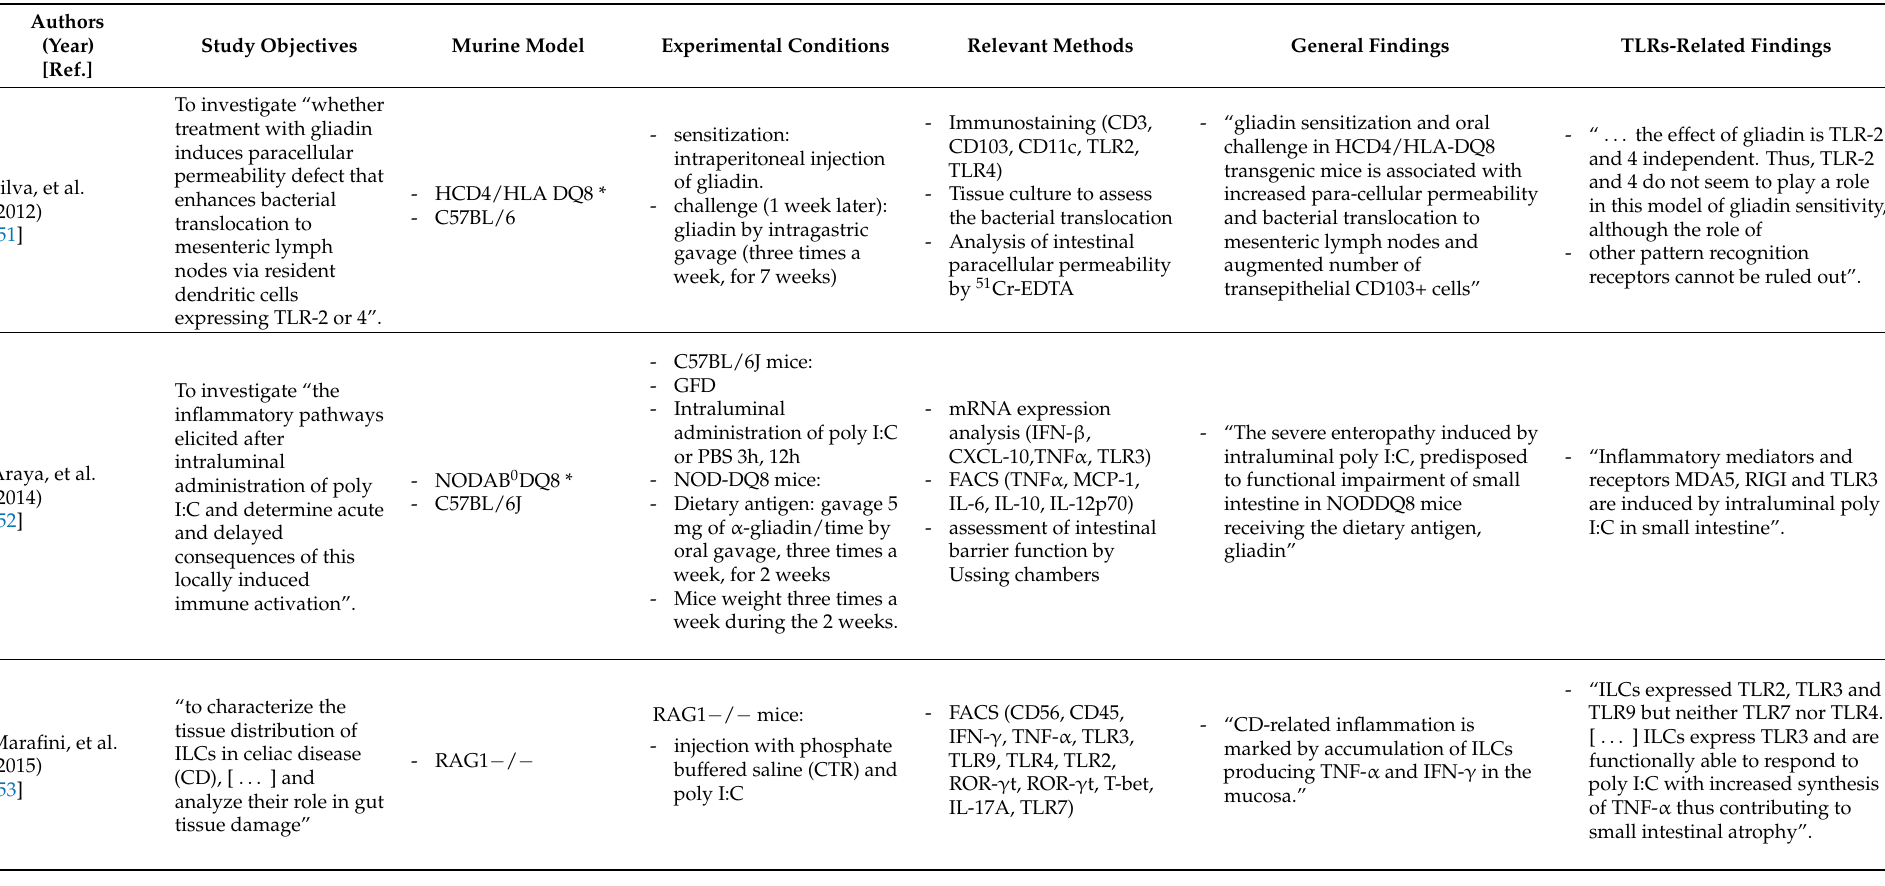
Table 3. Animal studies assessing TLRs in the response of innate cells to gluten